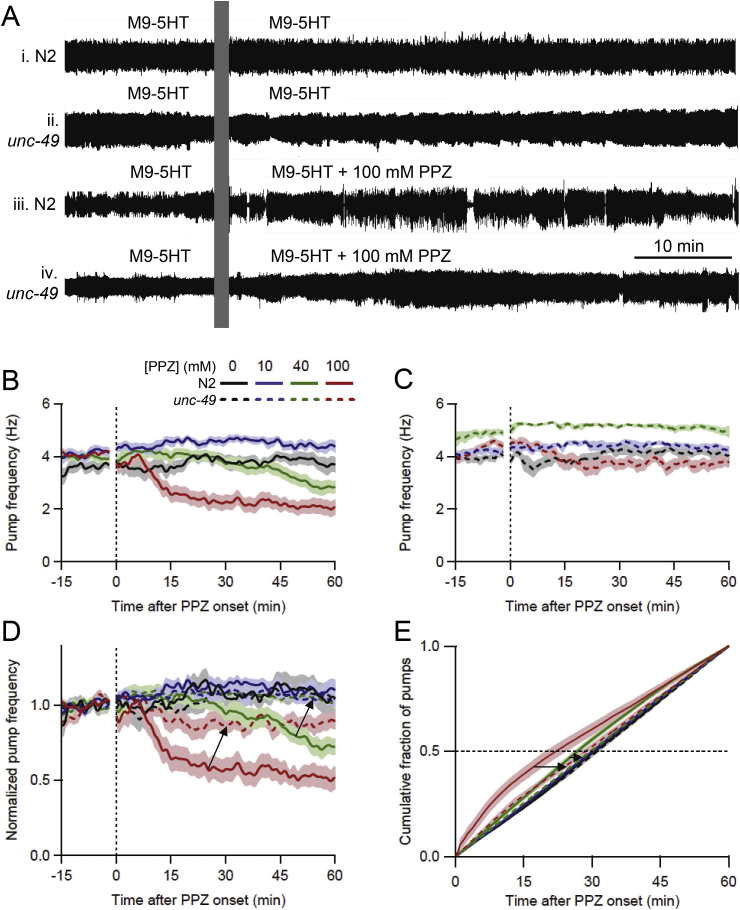
unc-49 (PPZ-resistant) worms are less sensitive to PPZ than N2s. A. Representative EPG recordings from individual worms, all perfused with M9-5HT during the baseline period. i, ii, N2 and unc-49 worms switched to M9-5HT (controls); iii, iv, N2 and unc-49 worms switched to 100 mM PPZ in M9-5HT. PPZ inhibited pumping more strongly in N2 than unc-49 worms. B, C. Pump frequency plotted over time for N2 (B) and unc-49 (C) worms switched at t = 0 min to different concentrations of PPZ (mean ± S.E.M., n = 17–29 worms/group). In all panels, concentrations are denoted by color and genotype by line type (solid, N2; dashed, unc-49). Perfusate switch occurred at the vertical dotted line, with the electrical artifact blanked. D. Same data as in B and C, displayed together after normalizing pump frequency. PPZ caused concentration-dependent inhibition of pumping in both strains; arrows denote reduced inhibition in unc-49 compared to N2 worms at 40 and 100 mM PPZ. E. Same data, plotted as the cumulative fraction (CF) of pumps occurring over time after perfusate switch at t = 0 min, for each genotype and PPZ concentration. Dotted line denotes CF50, the intercept at which statistical comparisons were made between groups. CF50 median values were (N2, unc-49, respectively, in minutes): 0 mM PPZ, 30.4, 30.7; 10 mM PPZ, 30.1, 30.1; 40 mM PPZ, 28.4, 29.9; and 100 mM PPZ, 22.3, 29.3. Arrows denote same difference between strains as in D. (For interpretation of the references to color in this figure legend, the reader is referred to the Web version of this article.)